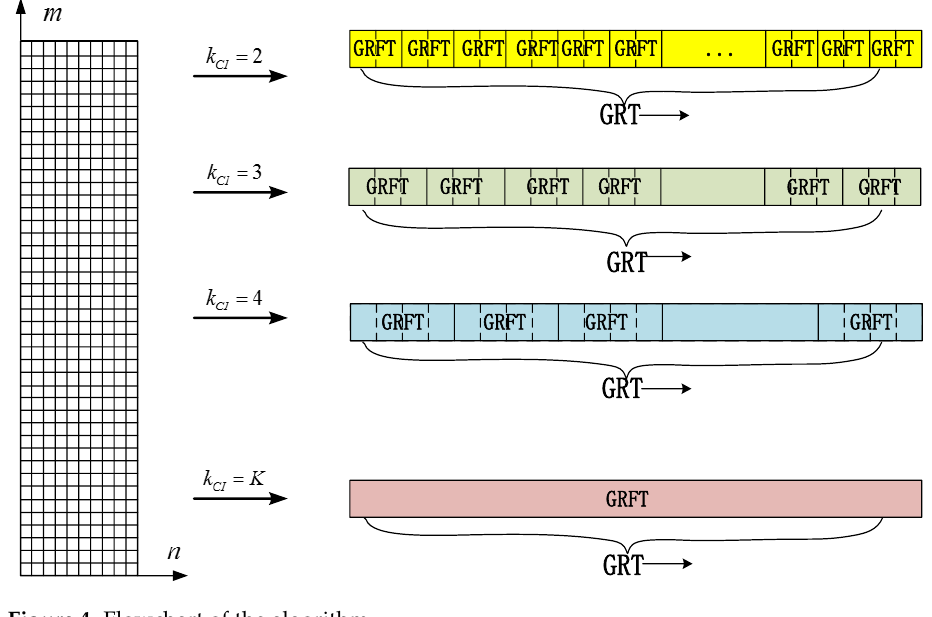
Figure 4. Flowchart of the algorithm.